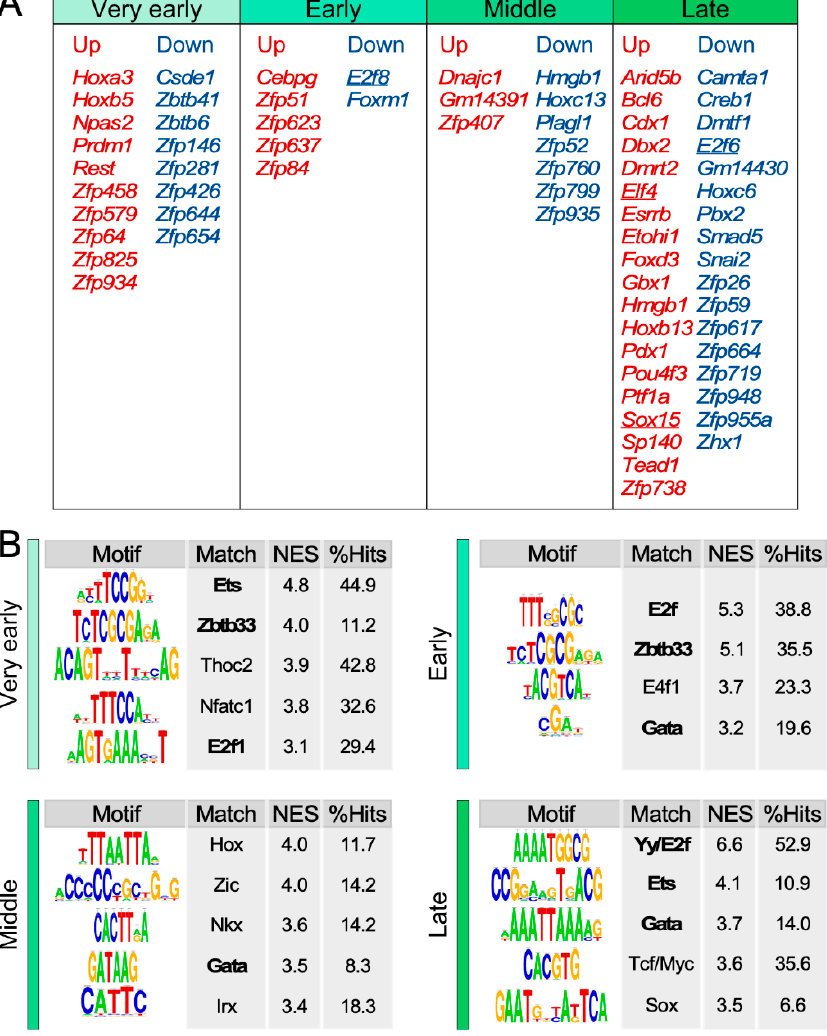
Figure 5. The dynamic expression patterns of SSCs are enriched in binding sites for specific transcription factors. ( A ) Up- (red) and downregulated (blue) transcriptional factors identified as hubs in the indicated experimental age intervals. Transcriptional factors also detected in the analyses shown in ( B ) are underlined. ( B ) Enriched transcription factor binding sites in the promoters of the hubs associated with each time-point gene expression program. The sequence logos, normalized enrichment score (NES), and the percentage of hits among the hubs are indicated. Transcriptional factors found in several age-points are depicted in bold.